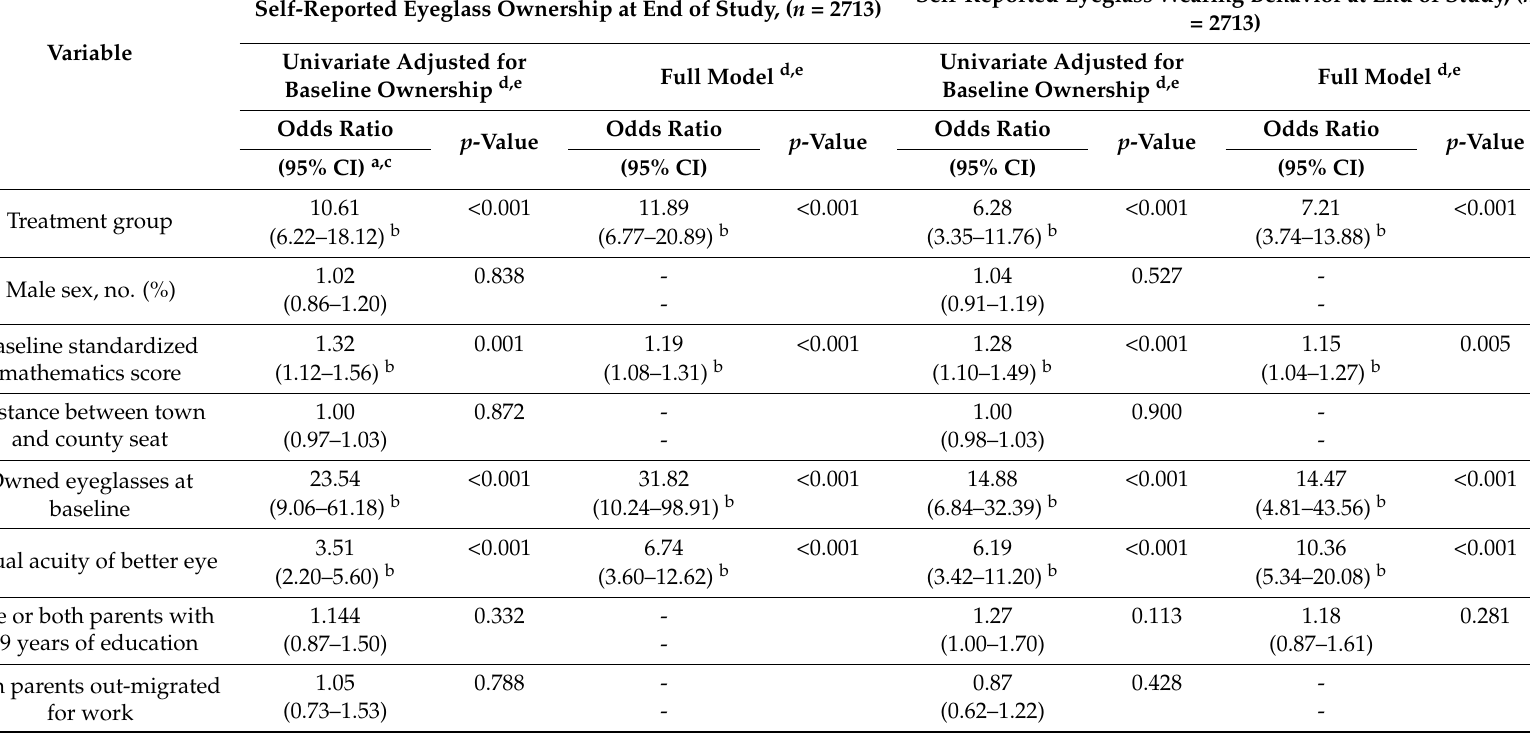
Table 3. Logistic Regression Model of Potential Factors Associated with Self-reported Ownership and Wearing behavior (Main outcome) of Glasses at End of Study. Self-Reported Eyeglass Ownership at End of Study, ( n = Variable